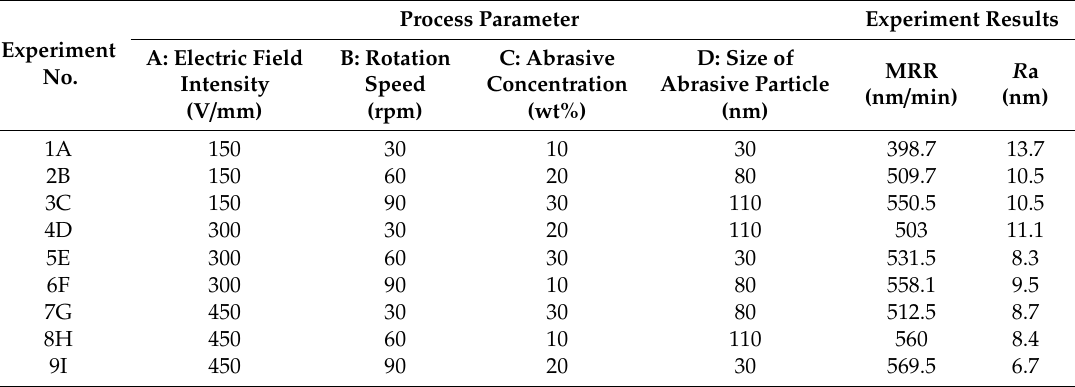
Figure 3. Measurement points in silicon wafer. Table 2. L9 (3 4 ) table of DEPP process parameter